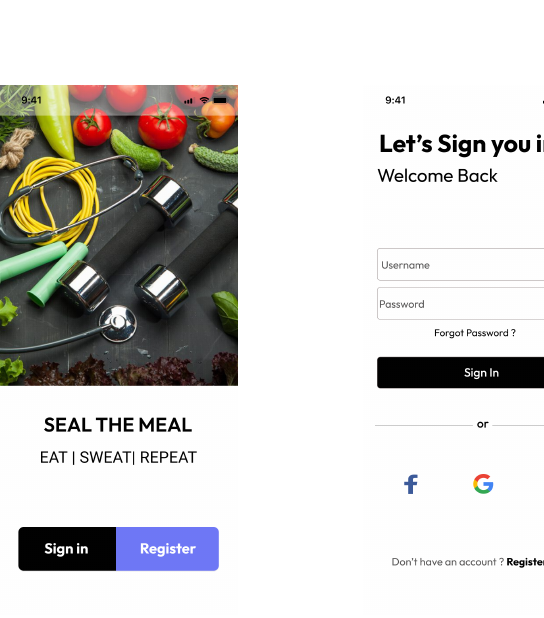
Figure 5. Registration Screen